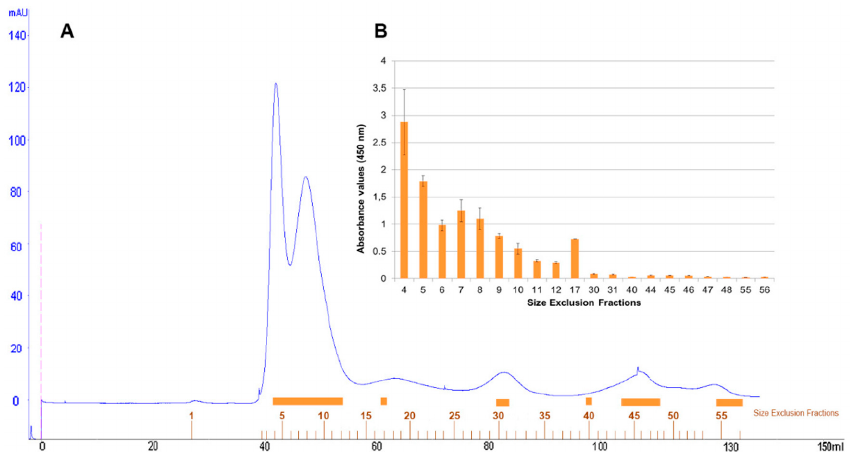
Figure 5. Elution profile of pistachio proteins obtained from preparative FPLC size exclusion column ( A ) showing absorbance values at 280 nm. ( B ) Indirect phage-dAb ELISA with some fractions obtained from FPLC (indicated by an orange bar). Absorbance values are the mean of duplicates. Error bars show the standard deviation for each set of data.